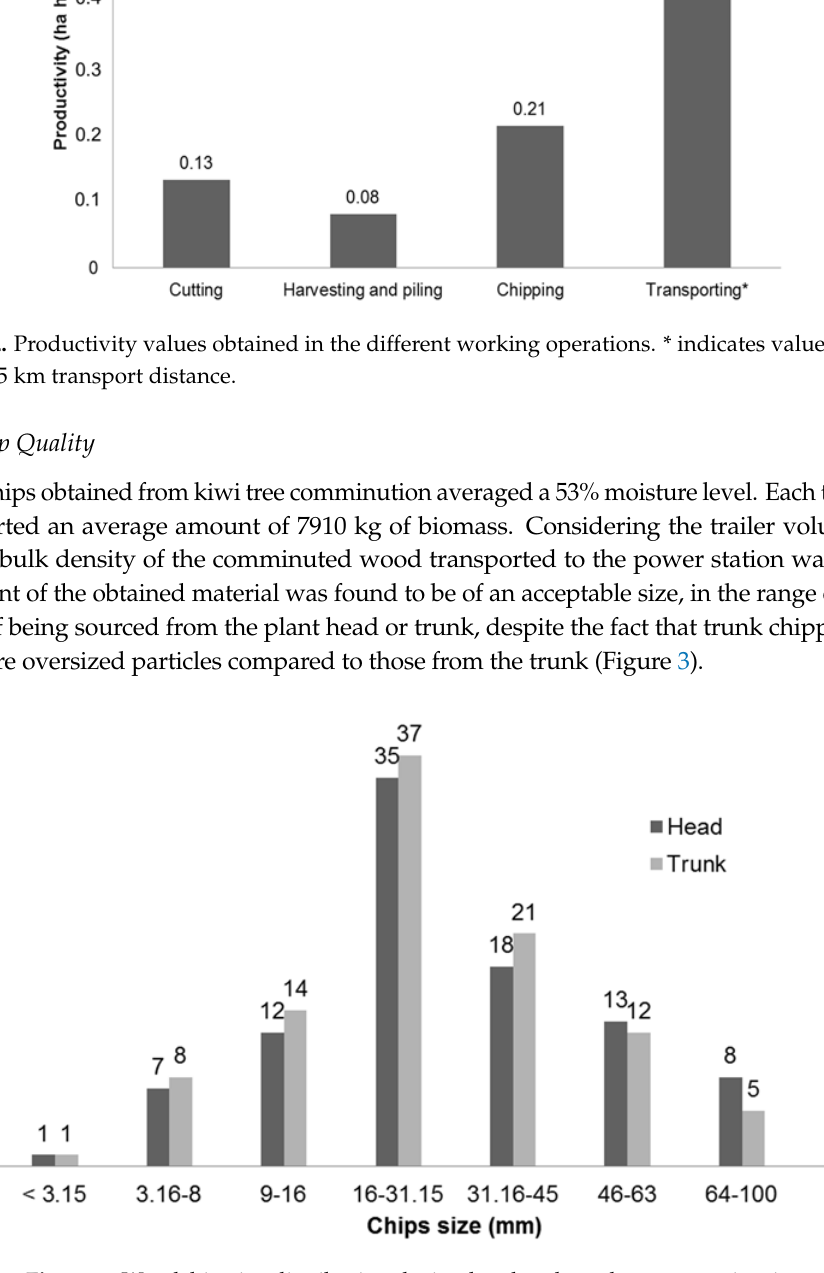
Figure 3. Woodchip size distribution during head and trunk tree comminution.